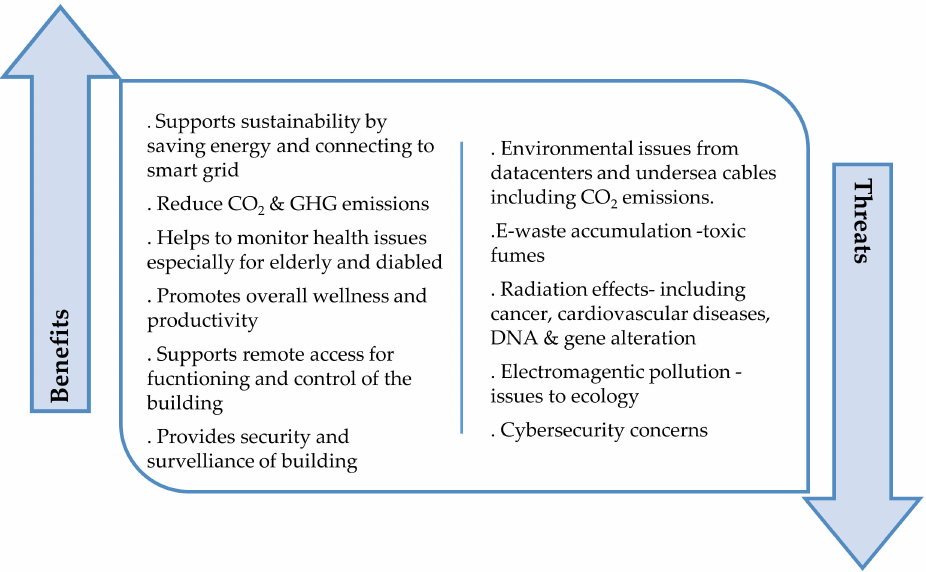
Figure 3. Benefits versus threats of smart